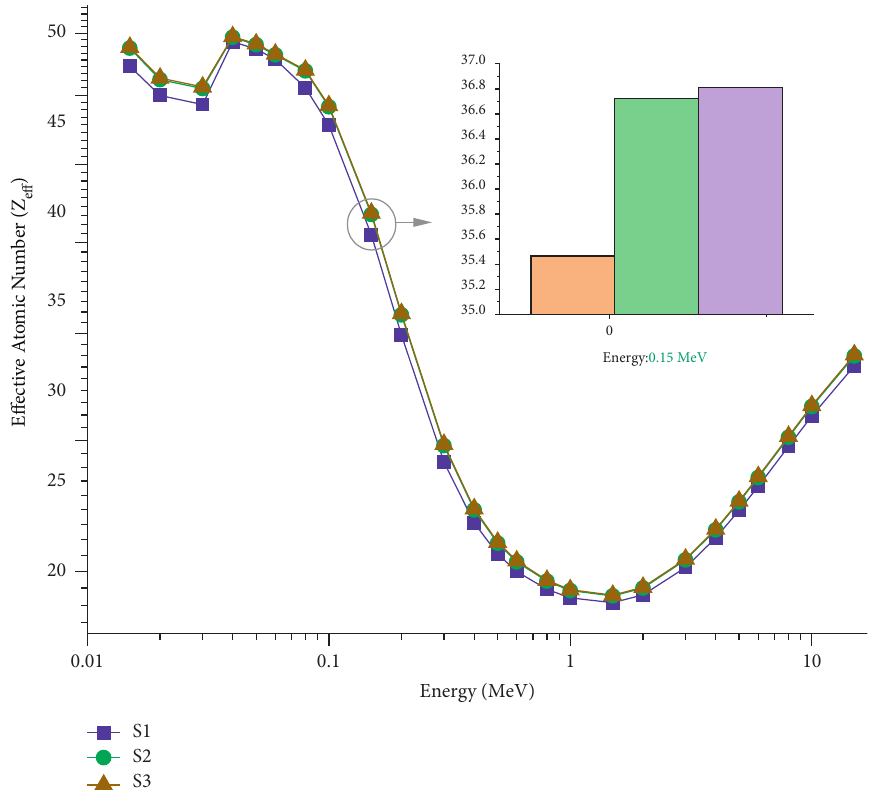
Figure 8: Variations of the effective atomic number (Z